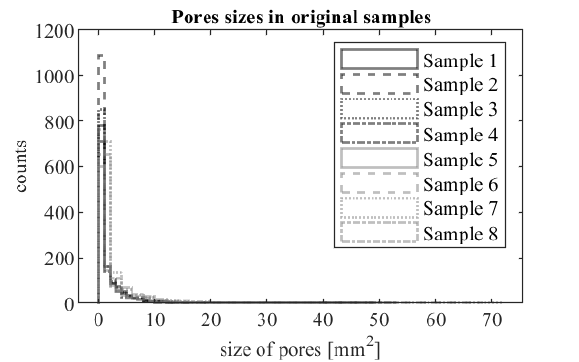
Figure 8. Histogram showing the counts of different size pores in the original samples (Fig. 7).